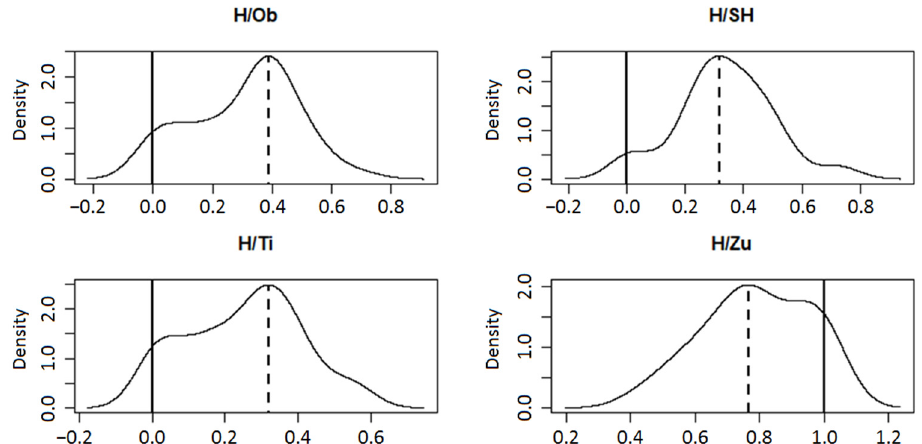
Figure 2. Hybrid index calculated for 80 iPBS loci in putative hybrid swarms Obsivanka (H/Ob), Sucha Hora (H/SH), Tisovnica (H/Ti), and Zuberec (H/Zu) (zero indicates pure P. mugo , one stands for pure P. sylvestris ). Density function with mode localization for a unimodal solution is shown. The dashed verticals represent the mode and the solid verticals represent the second possible mode.